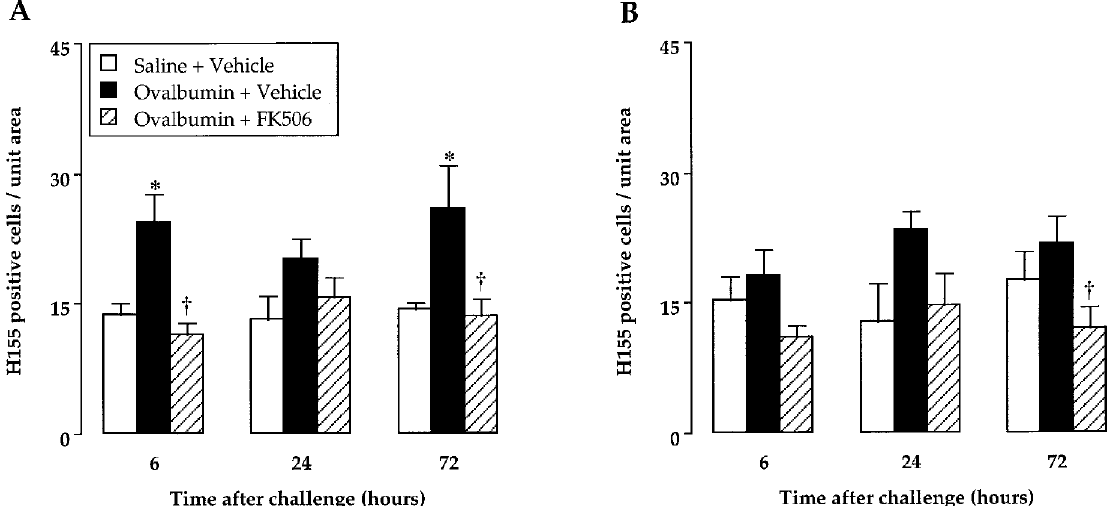
FIG. 5. Kinetics of the effect of FK506 on antigen-induced CD4 + T-lymphocyte infiltration into the bronchial mucosa of sensitized guinea-pigs (H155 staining and immunoperoxidase). Sensitized vehicle- or FK506 (0.1mg/kg)-treated animals were challenged with intra-nasal saline or ovalbumin and lungs collected 6, 24 or 72h thereafter. Results are means ± SEM of six experiments. * P < 0.05, compared with saline-challenged vehicle-treated guinea-pigs. † P < 0.05, compared with ovalbumin-challenged vehicle-treated guinea-pigs.